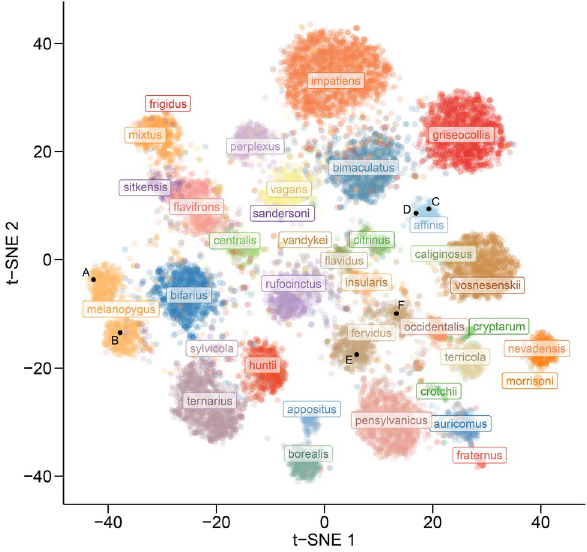
Figure 2. Visualization of trait separation among species based on t-SNE. Black points ( A–F ) show the location in trait space of images in Fig. 1